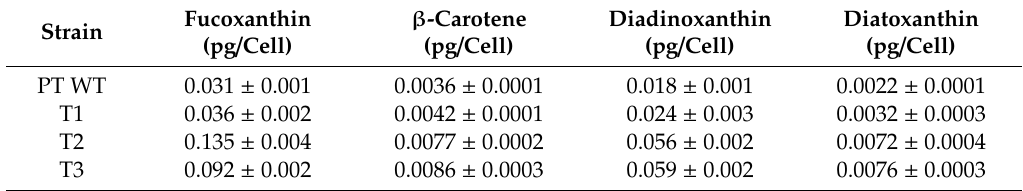
Table 2. Carotenoid content (pg / cell) in P. tricornutum wild type (PT WT) and transgenic (T1, T2, T3) strains. Data represent mean ( n = 3) and